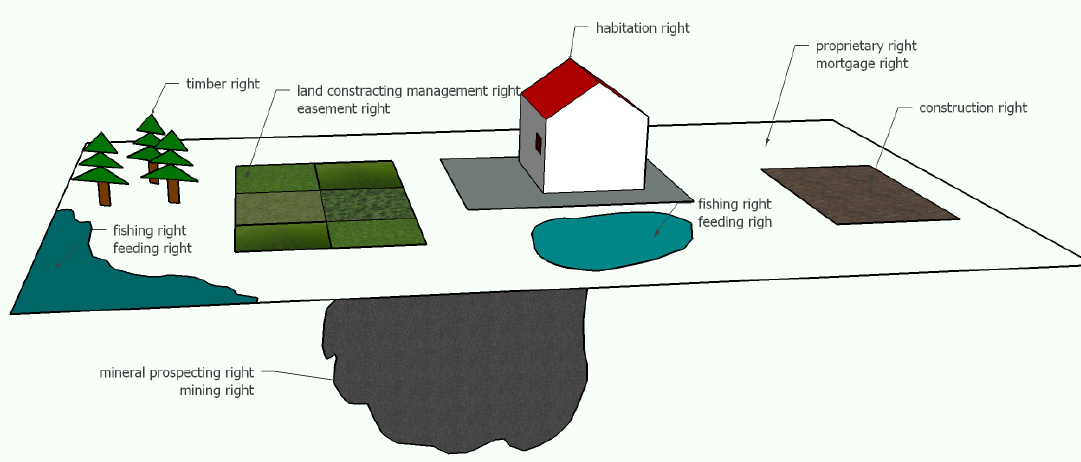
Figure 2. Relationship between spatial objects and rights.